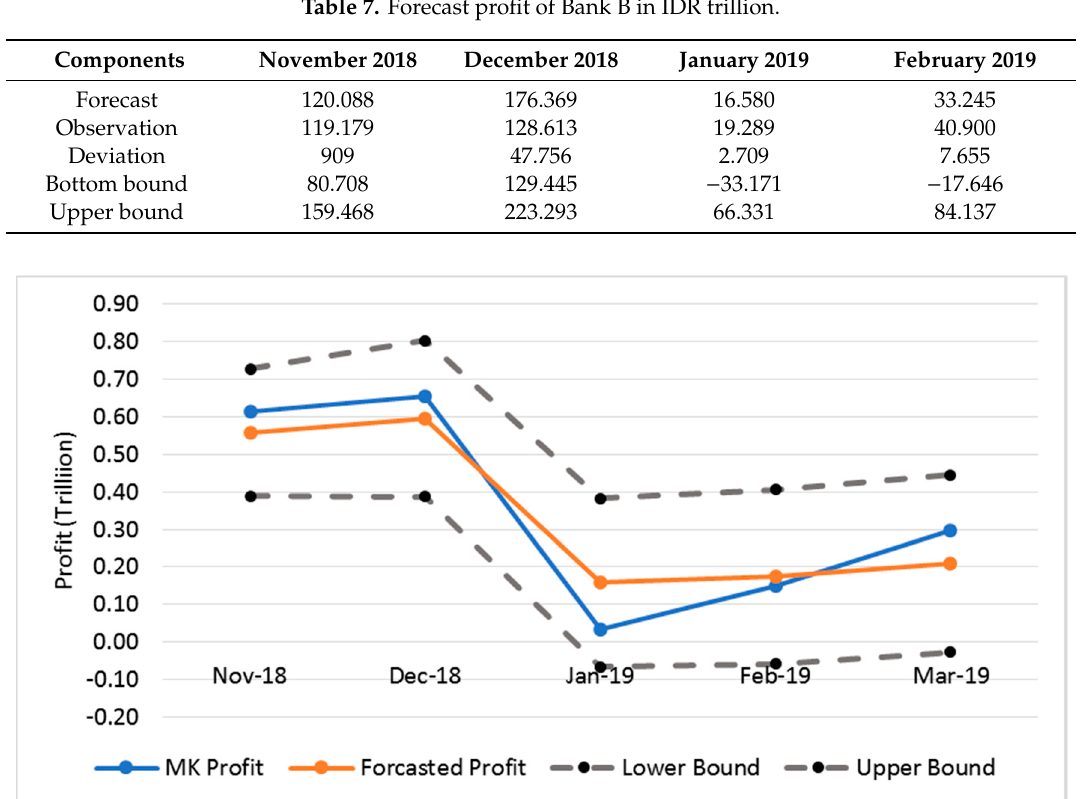
Figure 10. Forecast profits in 95% confidence interval of Bank C. Table 8. Forecast profit of Bank C in IDR million.